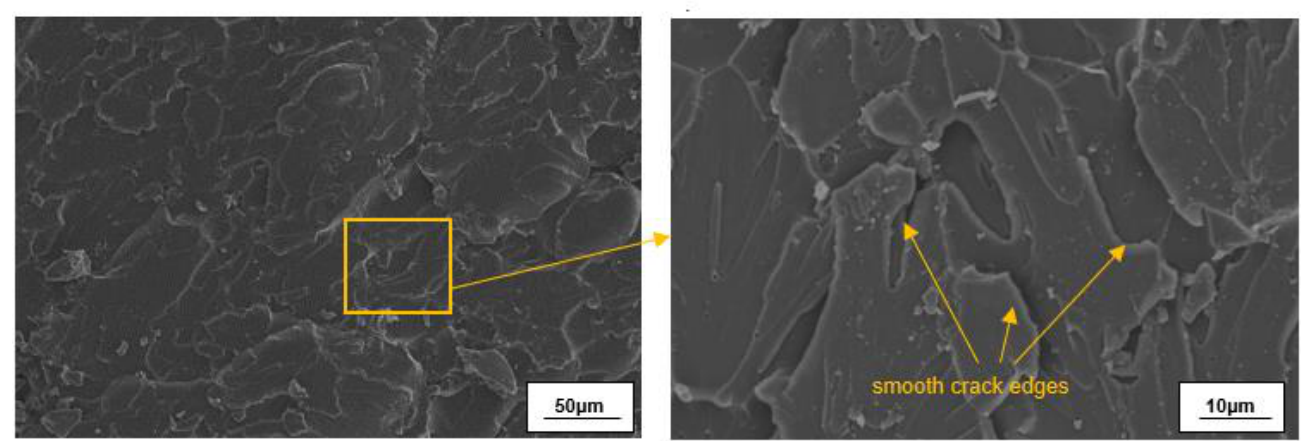
Figure 8. SEM micrographs of the impact fracture surface of the crosslinked sample of reference sample ESBO_BPA. sample